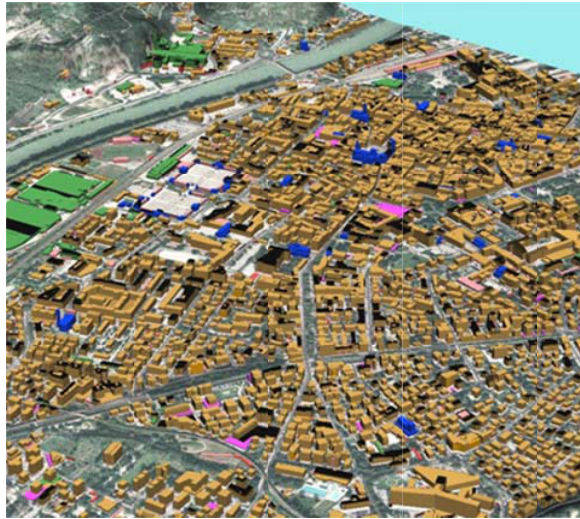
Figure 26: colourised by Cartography